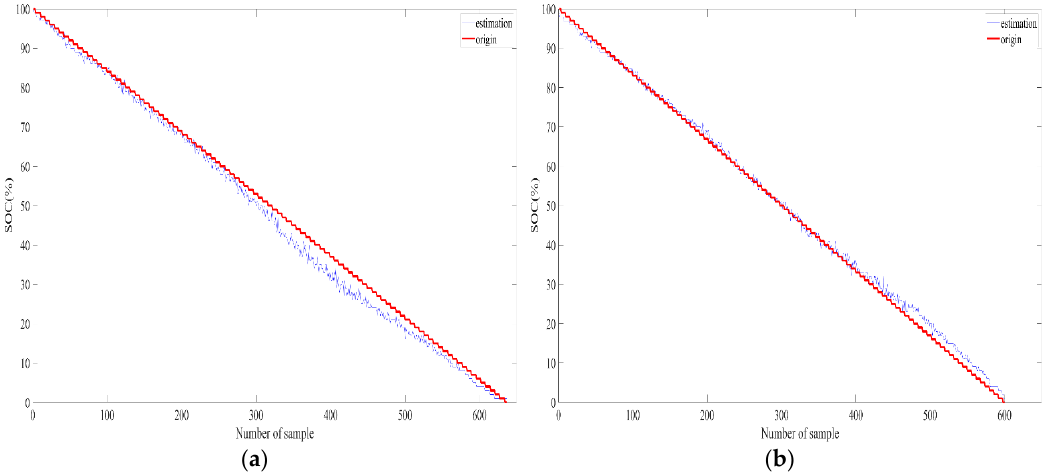
Figure 8. SOC estimation results ( a ) Using the MNN utilizing only 6 voltage as the input value at room temperature ( b ) Using the MNN utilizing only 6 voltage as the input value at high temperature.